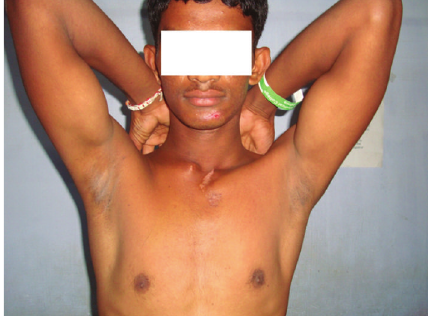
Figure 3: Clinical photograph showing full range of shoulder abduction at 18-month follow-up.